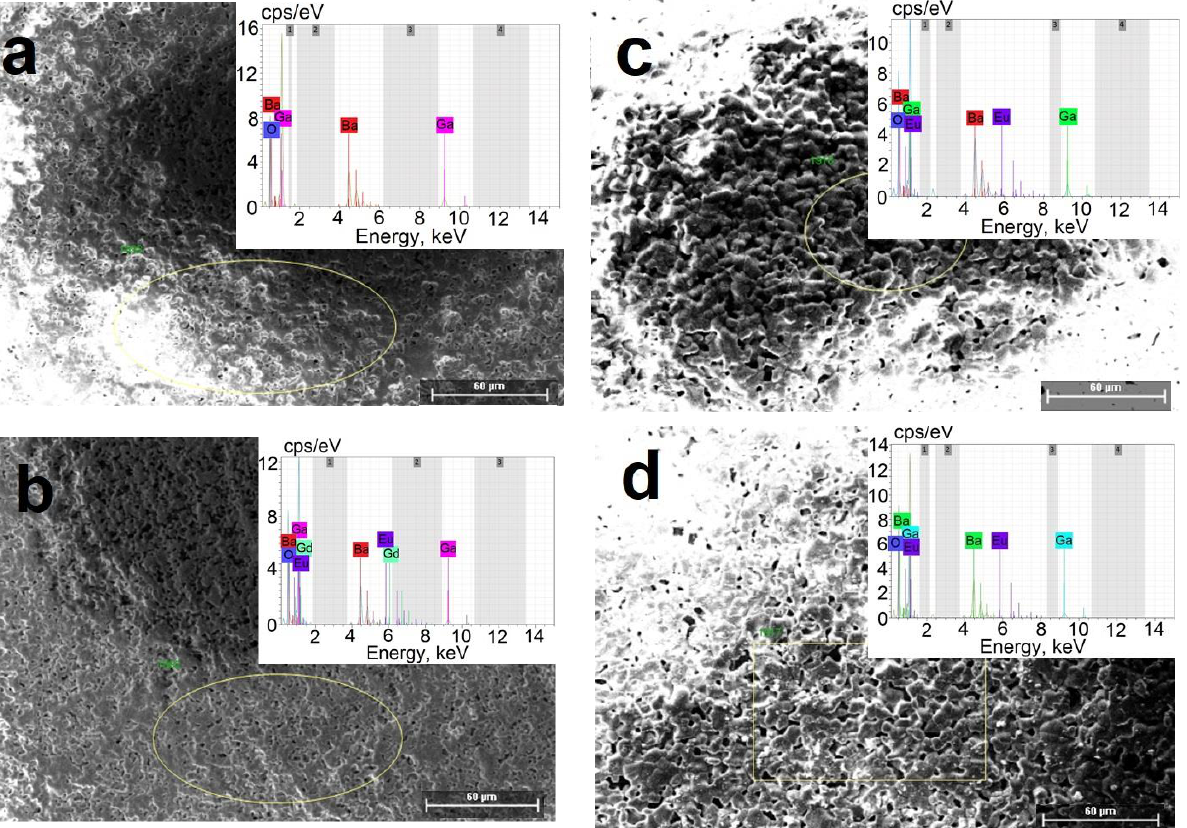
Figure 3. Microstructure of the selected areas and elemental composition of the undoped BaGa 2 O 4 ceramics ( a ) and those doped with 1 mol.% ( b ), 3 mol.% ( c ) and 4 mol.% of Eu 3+ ions ( d ). Table 2. Elemental composition of the undoped and Eu 3+ -doped BaGa 2 O 4 ceramics.